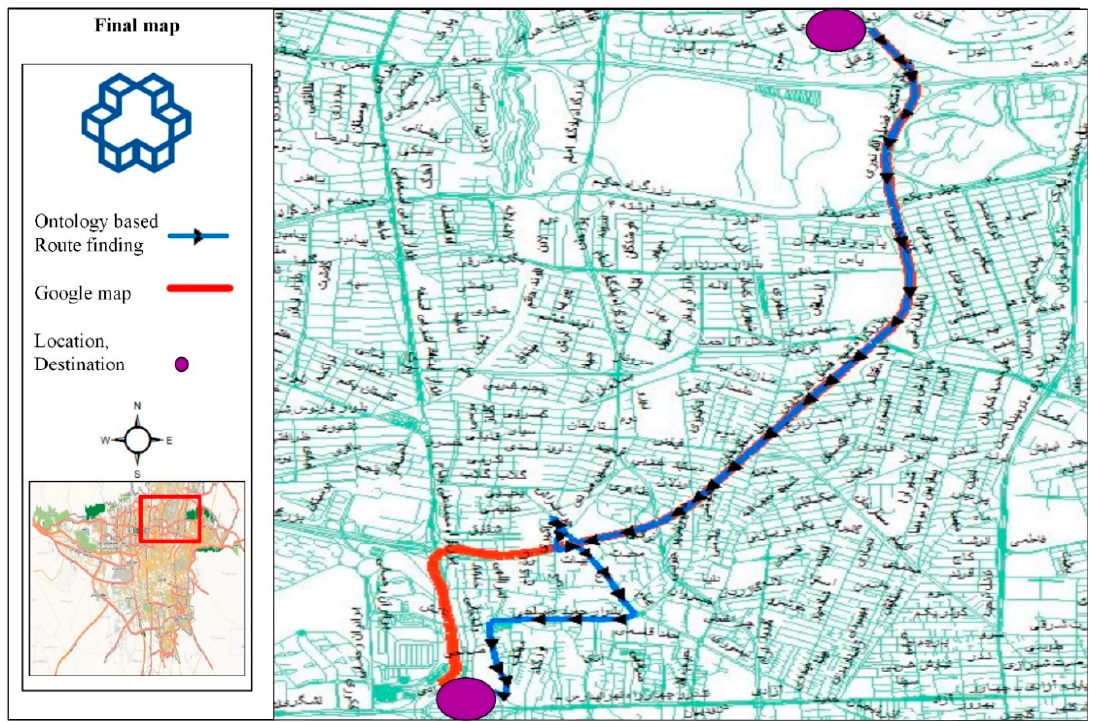
Figure 10. Comparison of two methods at off-peak traffic times.